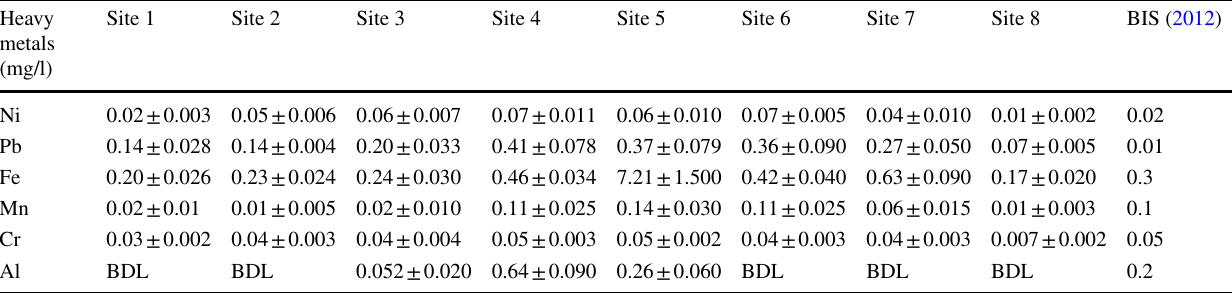
Table 2 Heavy metal concentration in groundwater near ash pond Heavy